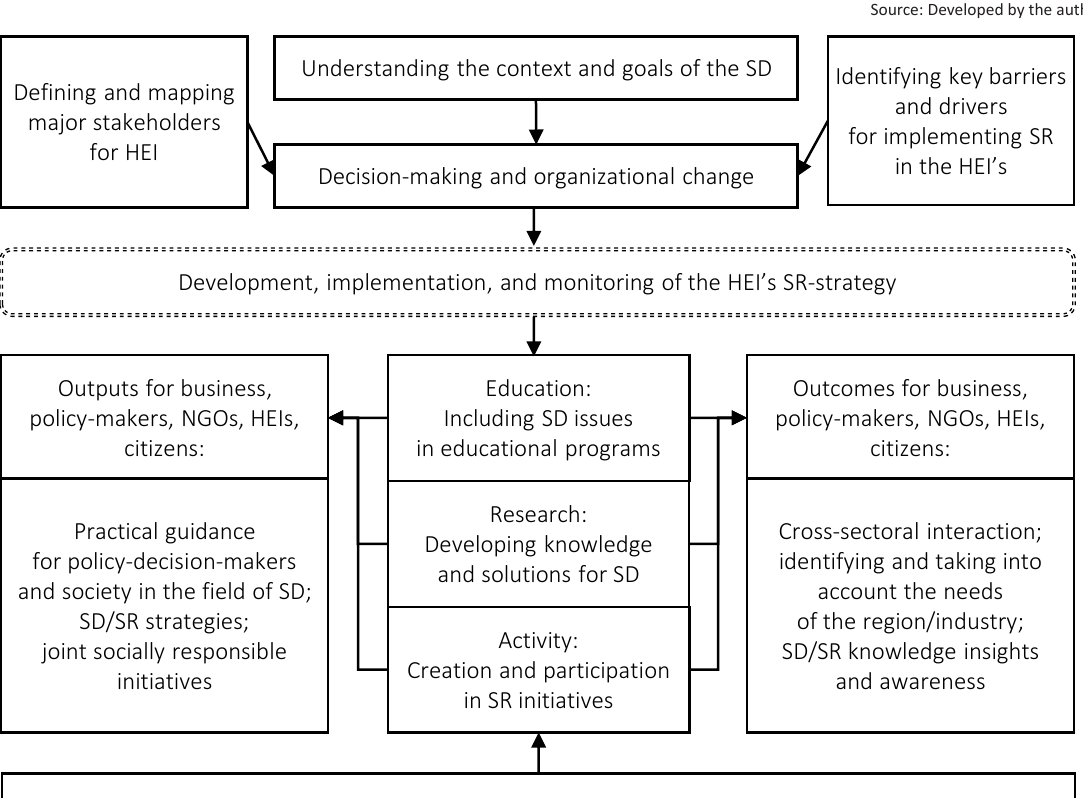
Figure 3. The mechanism of HEIs impact on SD through the implementation of SR